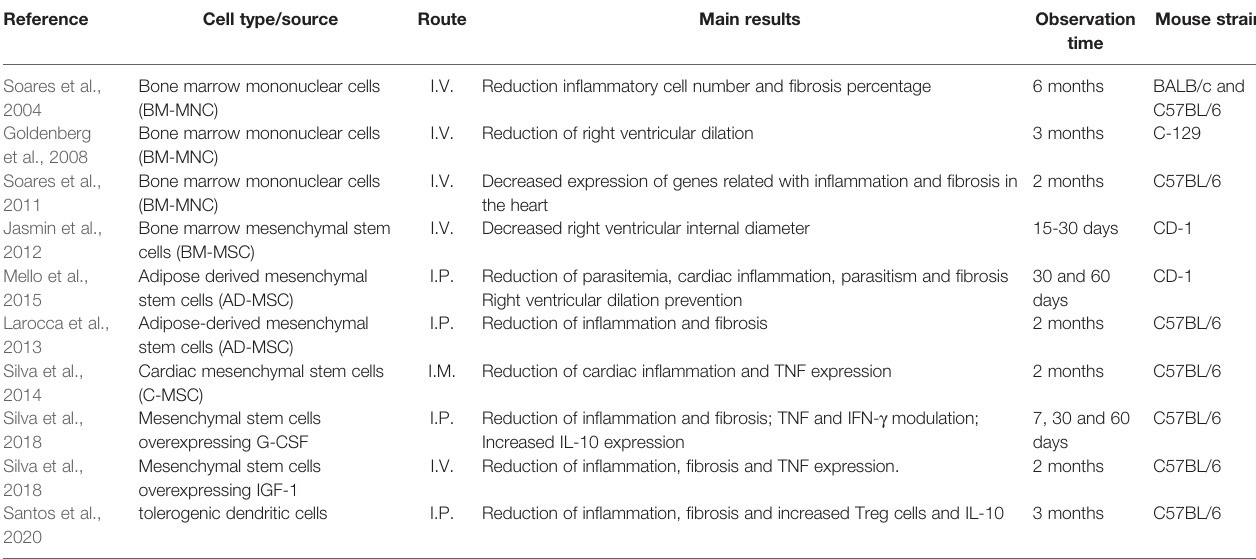
TABLE 2 | Cell therapy studies in mice models of chagasic